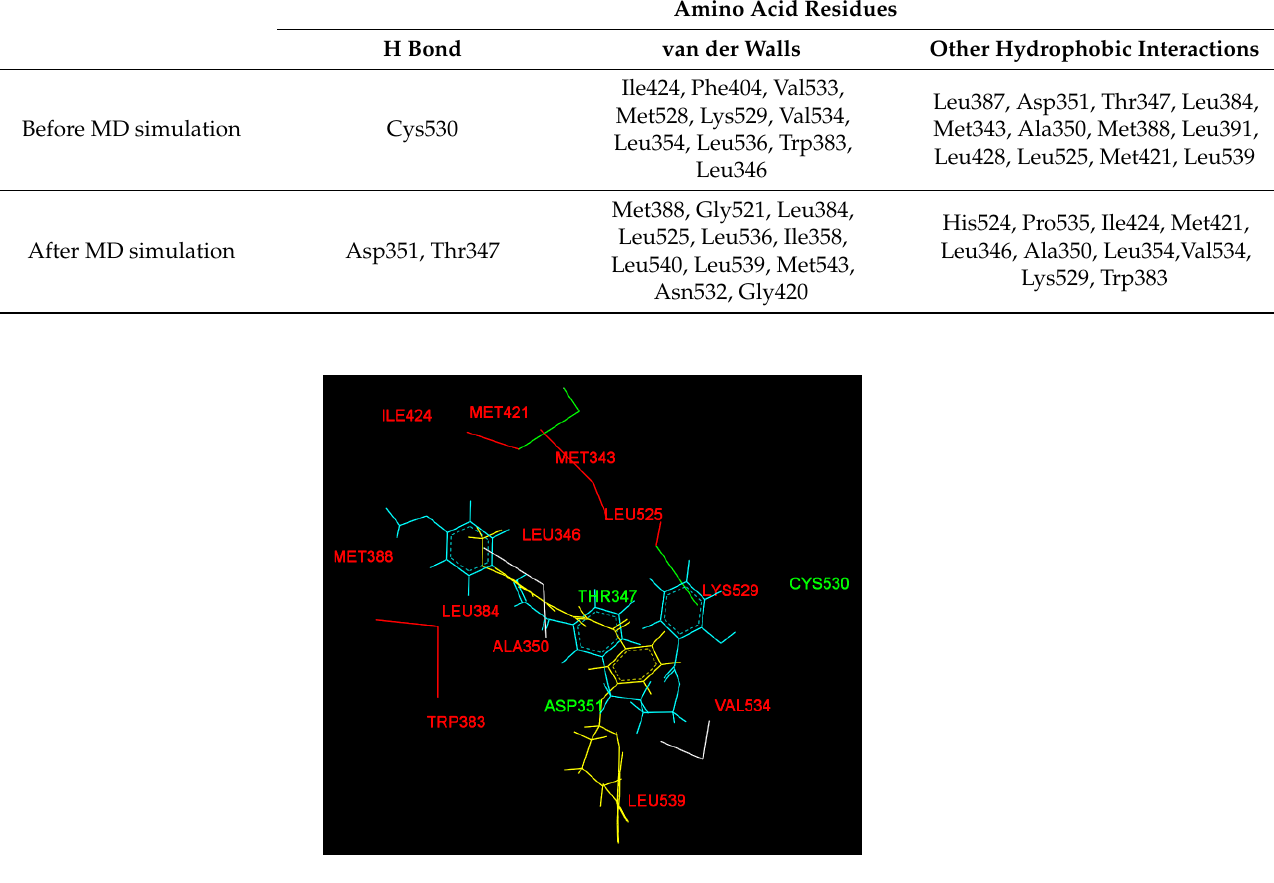
Figure 6. The 3D visualization of superimposition of binding poses of the title compound before and after MD simulation. Binding pose before MD simulation is presented in blue and after MD is presented in yellow. The amino acid residue with hydrogen bond is presented in green and the other maintained interactions during MD simulation are presented in red.